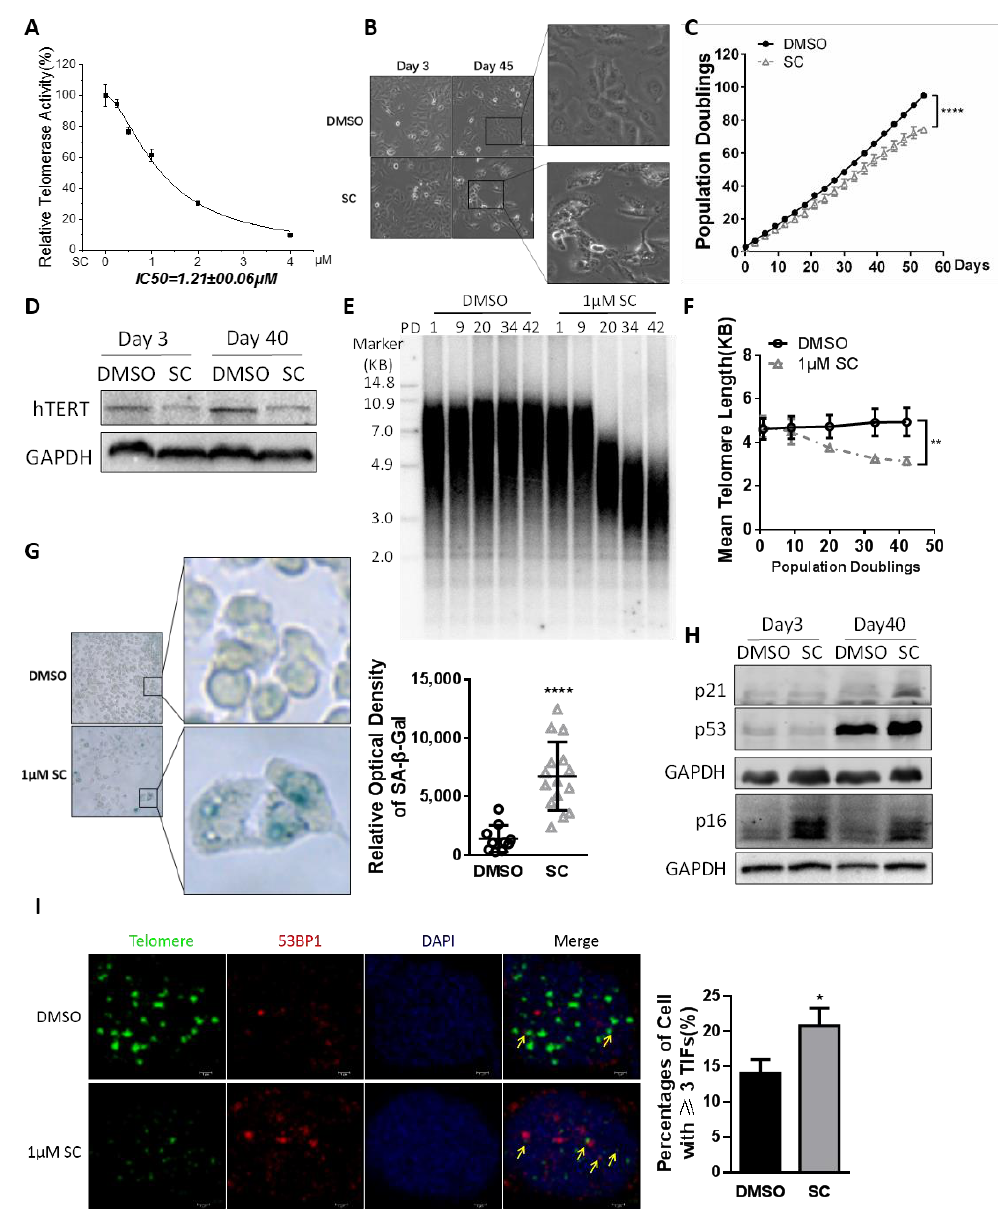
Figure 3. Continuous treatment with SC led to cell senescence in cancer cells. ( A ) Fitting curve of inhibitory effect of SC on RTA in HTC75 cells. IC50 = 1.21 µ M. ( B ) Morphology of HTC75 cells treated with 1 µ M SC versus DMSO between day 3 and day 45. ( C ) The cell growth curve of the HTC75 cells continuously treated with 1 µ M SC, comparing to DMSO-treated groups. ( D ) Western blotting analysis to confirm the inhibitory effect of SC on hTERT protein level. GAPDH served as an internal reference. ( E ) HTC75 cells continuously treated with 1 µ M SC were analyzed by terminal restriction fragment (TRF) assay. ( F ) Quantitative average telomere length from ( E ). ( G ) SA- β -gal staining assay to identify cell senescence in HTC75 cells continuously treated with 1 µ M SC. ( H ) The senescence markers p16/p21/p53 were up-regulated in cancer cells after chronic treatment of the compound. ( I ) Telomere dysfunction-induced foci (TIFs) were analyzed using anti-53BP1 antibody (red) and PNA-conjugated telomere C strand probe (green) when HTC75 cells were treated with the compound for 40 days. Cells with TIFs ≥ 3 were counted for the significance test. The experiments were performed in 3 independent cell lines and the results are shown as mean ± SD, n = 3 (* p < 0.05, ** p < 0.01, **** p <